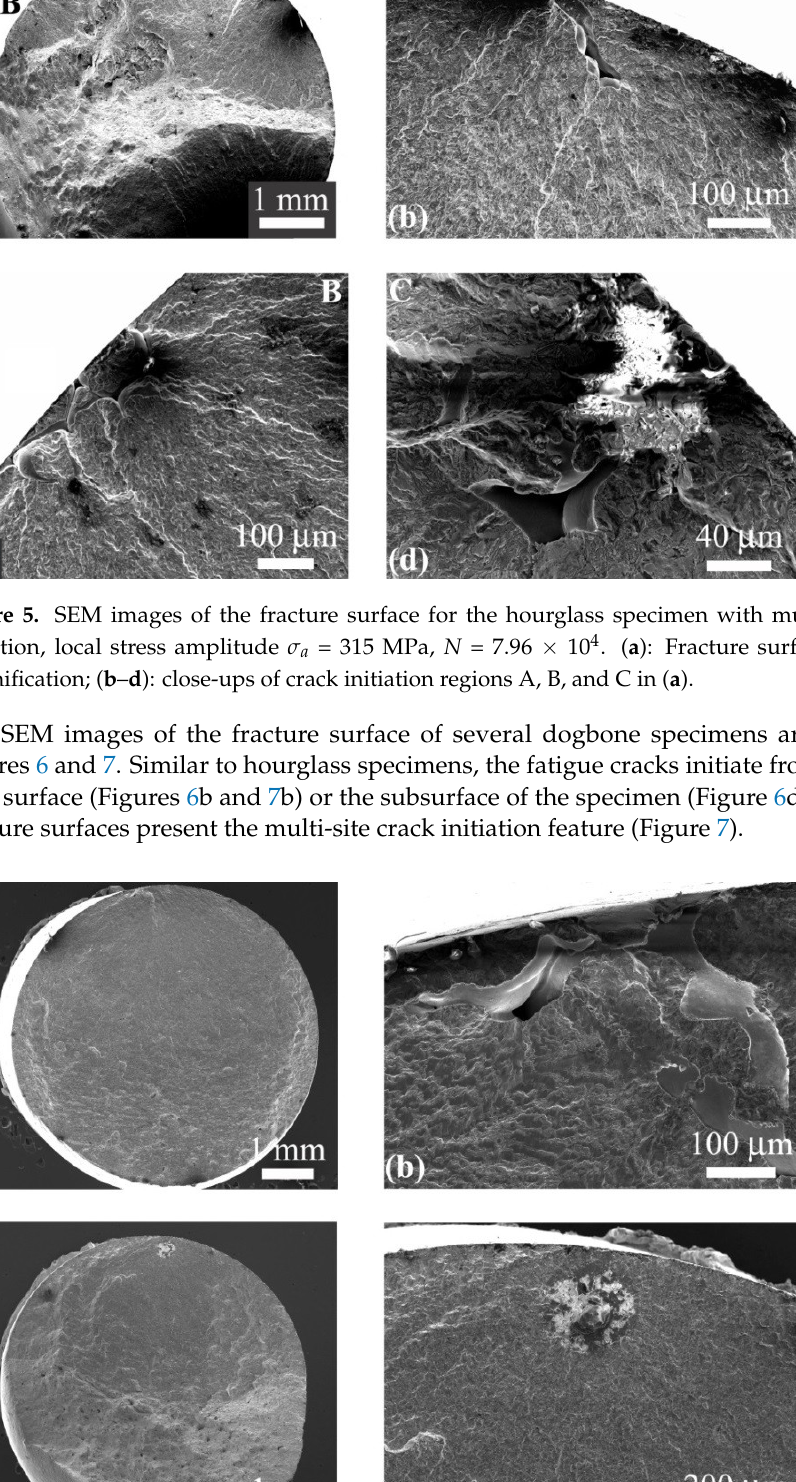
Figure 4. SEM images of the fracture surface for hourglass specimens with single-site crack initia- tion. ( a ) and ( b ): local stress amplitude σ a = 315 MPa, N = 1.73 × 10 5 ; ( c ) and ( d ): local stress amplitude σ a = 252 MPa, N = 1.37 × 10 5 .